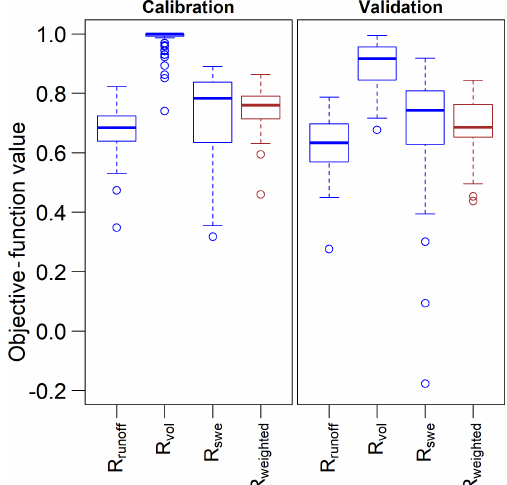
Figure 2. Results of model calibration and validation for study catchments. The objective function value for each catchment rep- resents a median from 100 parameter sets. Boxes represent the 25th and 75th percentile (with median as a thick line); whiskers represent a 1.5 multiplier of the interquartile